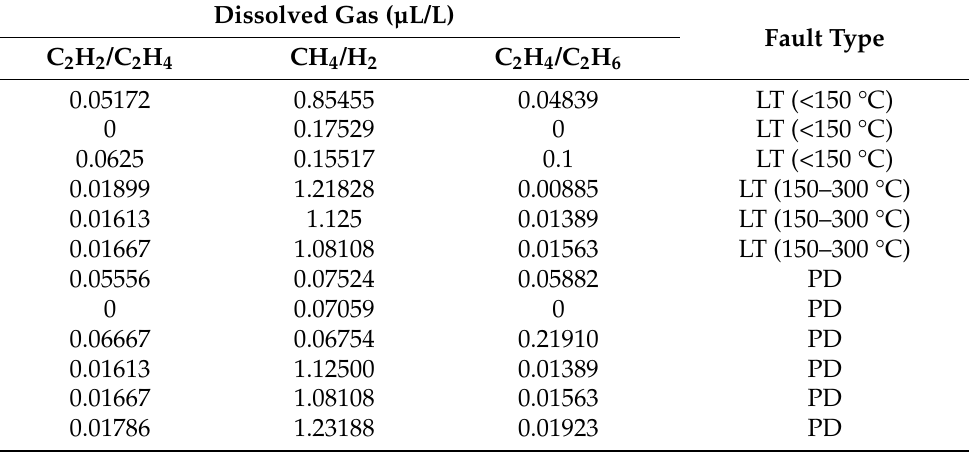
Table 3. Partial sample